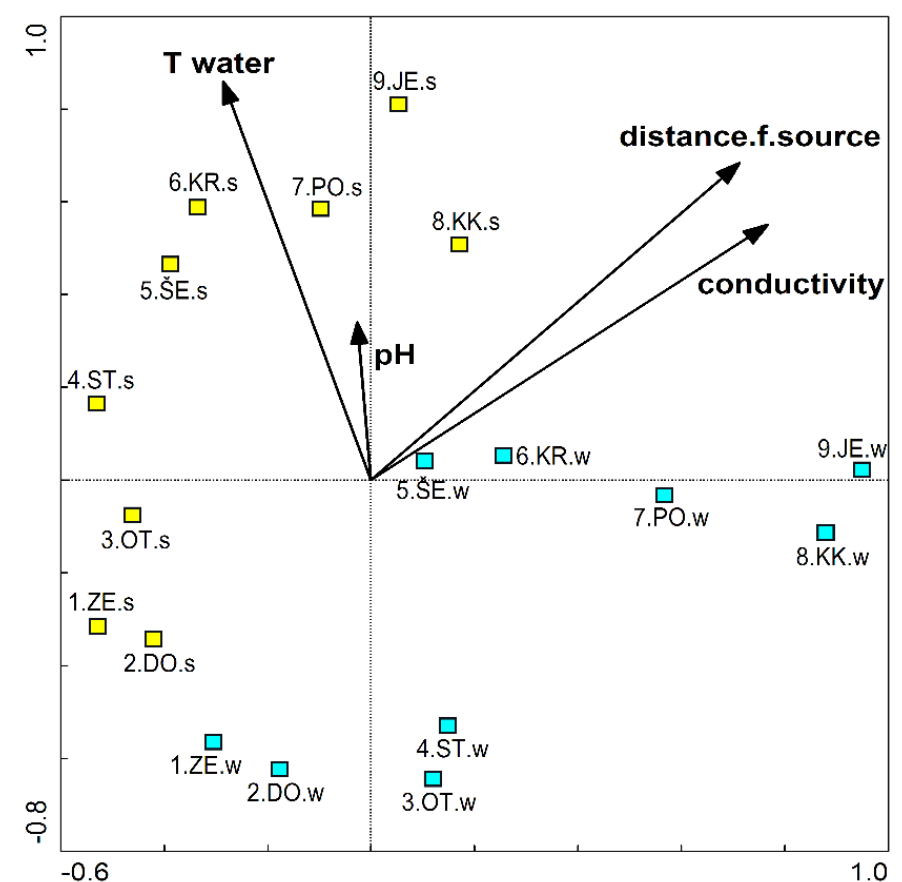
Figure 3. Ordination diagram of the samples and significant parameters ( p < 0.05) according to redundancy analysis (RDA). Blue symbols represent winter samples (e.g., 1.ZE.w etc.), and yellow symbols represent summer samples (e.g., 1.ZE.s).